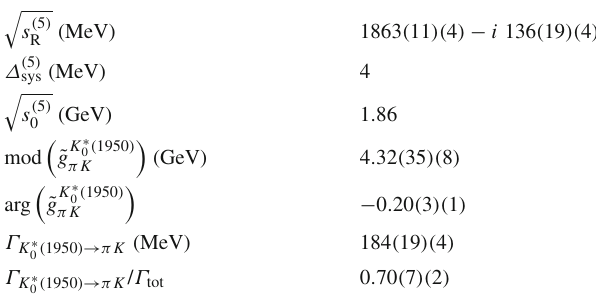
Fig. 9 Uncertainty regions Δ ( N ) sys as defined in Eq. (53) for the optimal value of s 0 on the pole position of the K ∗ Table 4 Results of Padé extractions at N = 5 for the K ∗ including statistical (first bracket) and systematic uncertainties (second